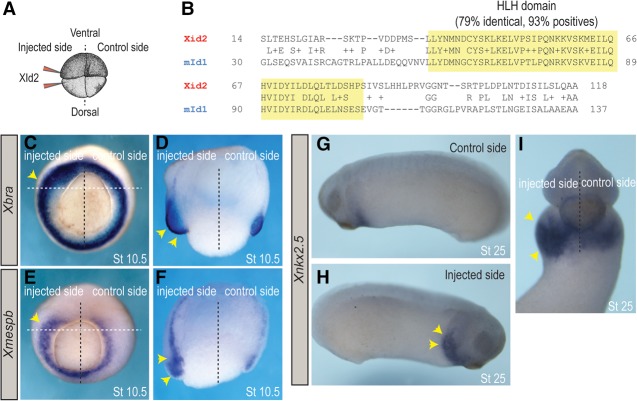
Id proteins promote cardiogenic mesoderm formation in vivo. (A) Xid2 mRNA was injected equatorially into two blastomeres on one side of four-cell stage embryos. (B) The mouse HLH domain of Id1 (NP_034625.1) was aligned and compared with all Xenopus laevis HLH (yellow) domains of id proteins using the Protein Blast tool (https://blast.ncbi.nlm.nih.gov). With 79% of identical amino acids, Xid2 (NP_001081902.1) (A) is the closest ortholog to Id1. (C–F) Unilaterally injected embryos (as in A) cultured to gastrula stage (stage 10.5) in whole mount (C,E) or transversely bisected (D,F) and probed for mesoderm marker Xbra (C,D) and cardiogenic mesoderm Xmespb (E,F) expression. Yellow arrowheads indicate expansions of both the Xbra and Xmespb domains in the Xid1-injected side. (G–I) Unilaterally injected embryos cultured to early tail bud stage (stage 25) in whole mount and probed for Xnkx2.5 expression. Yellow arrowheads indicate an expansion of the Xnkx2.5 domain in the Xid2-injected side of the embryo.